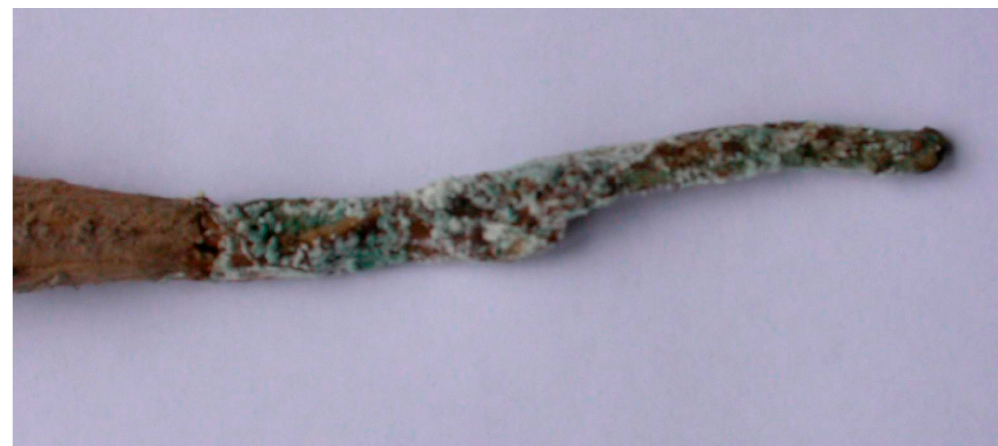
Figure 2. Scorzonera roots after harvest; (photo by E. Patkowska).